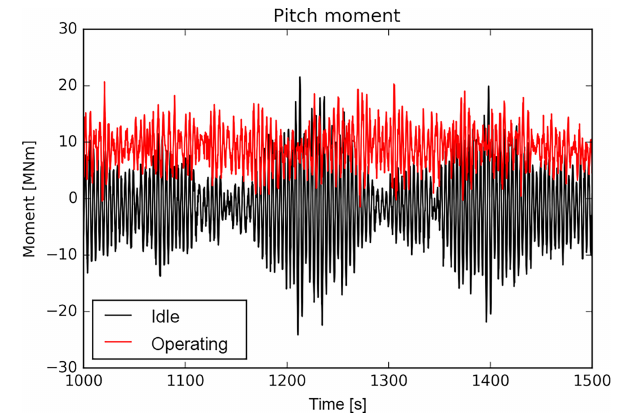
Figure 24. Accumulated fatigue damage at tower root arranged by load